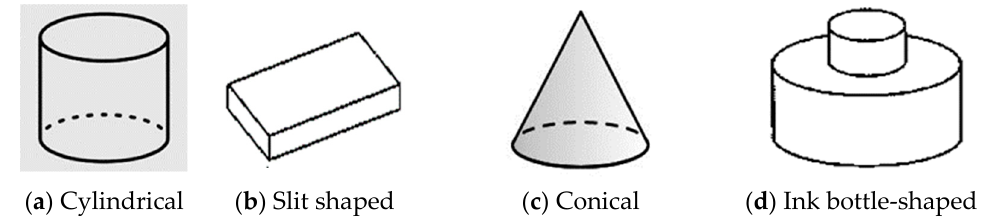
Figure 1. Classification of pores based on